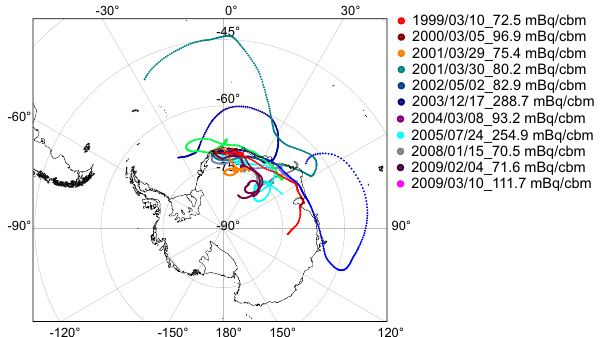
Fig. 5. The 10-day back trajectories for highest 222 Rn activity con- centrations.